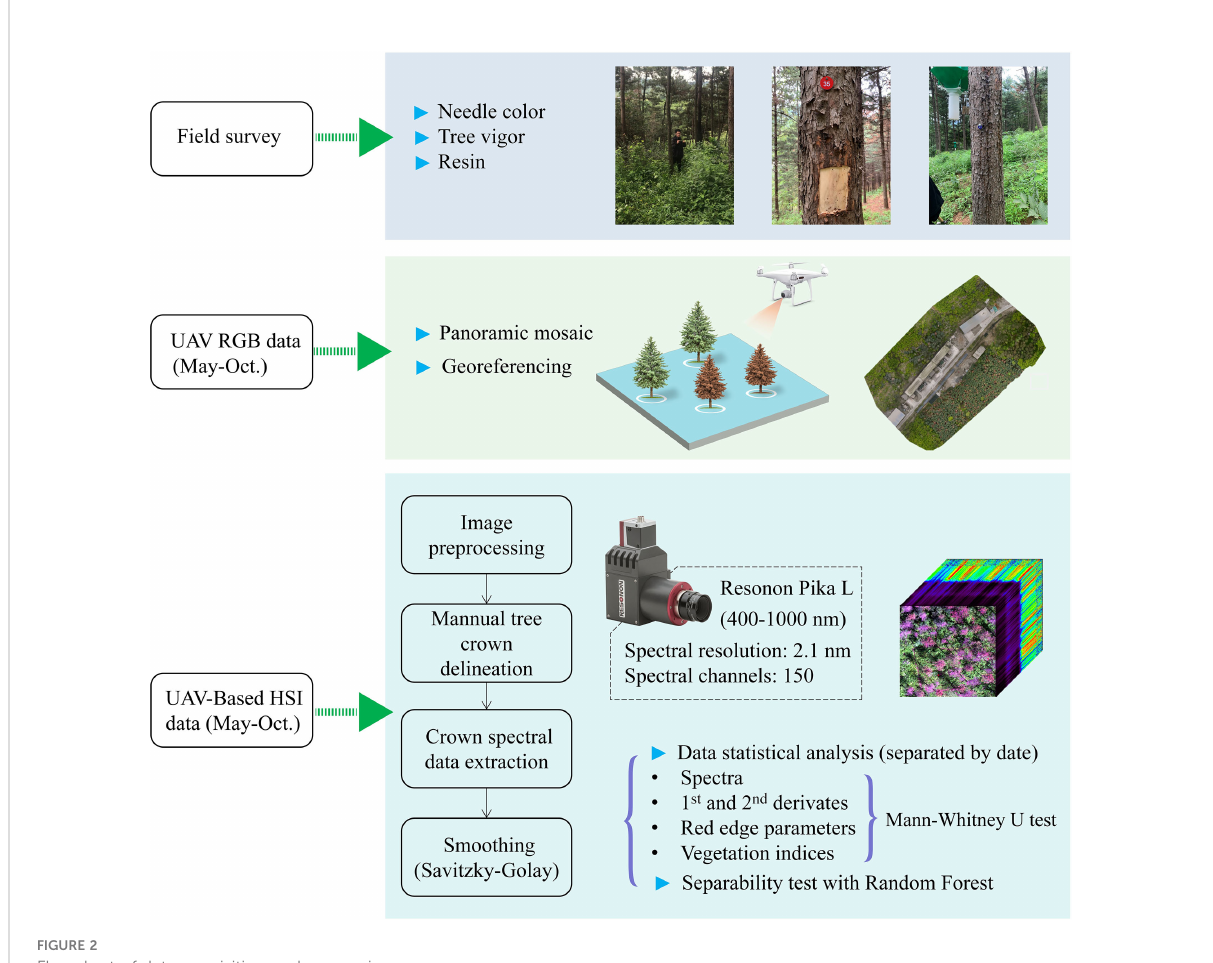
FIGURE 2 Flowchart of data acquisition and